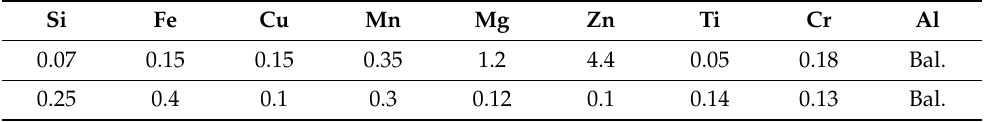
Table 1. Chemical compositions of 7005 and ER5356 wt%.